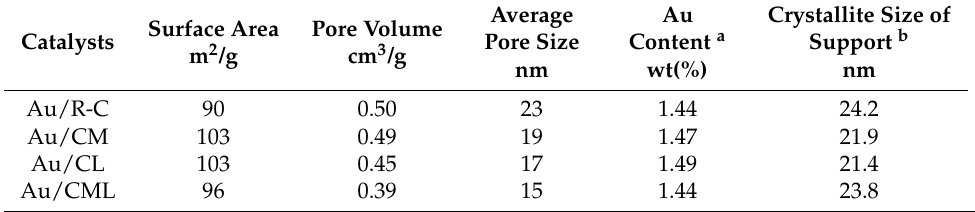
Table 1. Physical and structural properties of the catalysts .